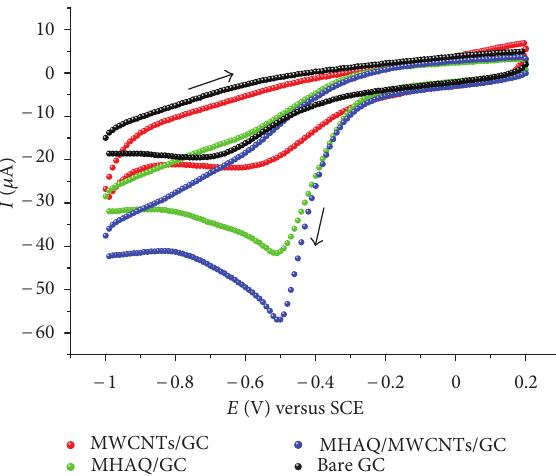
F 5: CVs for the MHAQ/MWCNTs/GC electrode in N saturated 0.1M KOH at scan rate of 20mVs correspond to the 1st, 10th, and 100th potential scans.